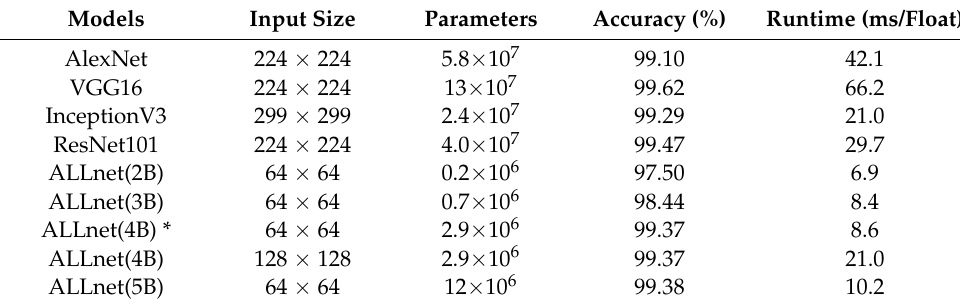
Table 3. Comparison with baseline CNNs.